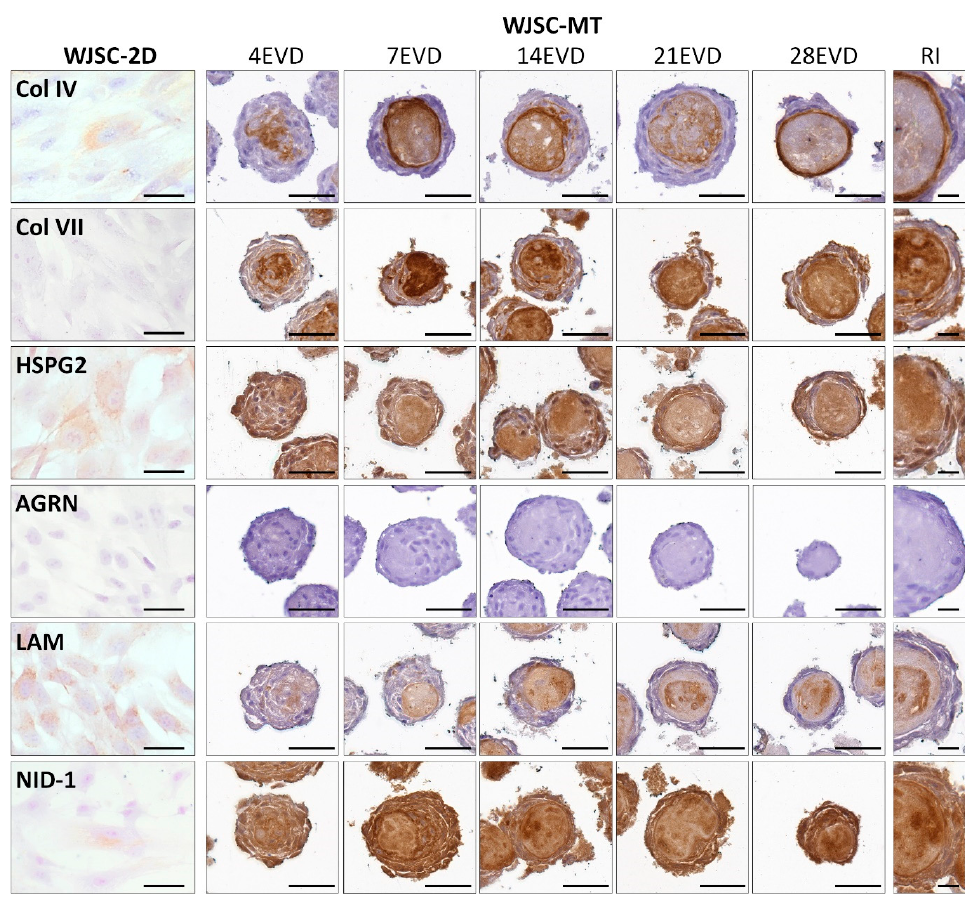
Figure 6. Immunohistochemical analyses of the basement membrane (BM) molecules (collagens type IV and VII (Col IV) (Col VII), proteoglycans heparan sulfate proteoglycan 2 (HSPG2) and agrin (AGRN) and glycoproteins laminin (LAM) and nidogen-1 (NID-1)) expressed in WJSC-2D and WJSC-MT culture methods at 4, 7, 14, 21 and 28 days of EVD. Representative images (RI) at higher magnification are shown on the right. Scale bar: 50 µm and 25 µm (RI).